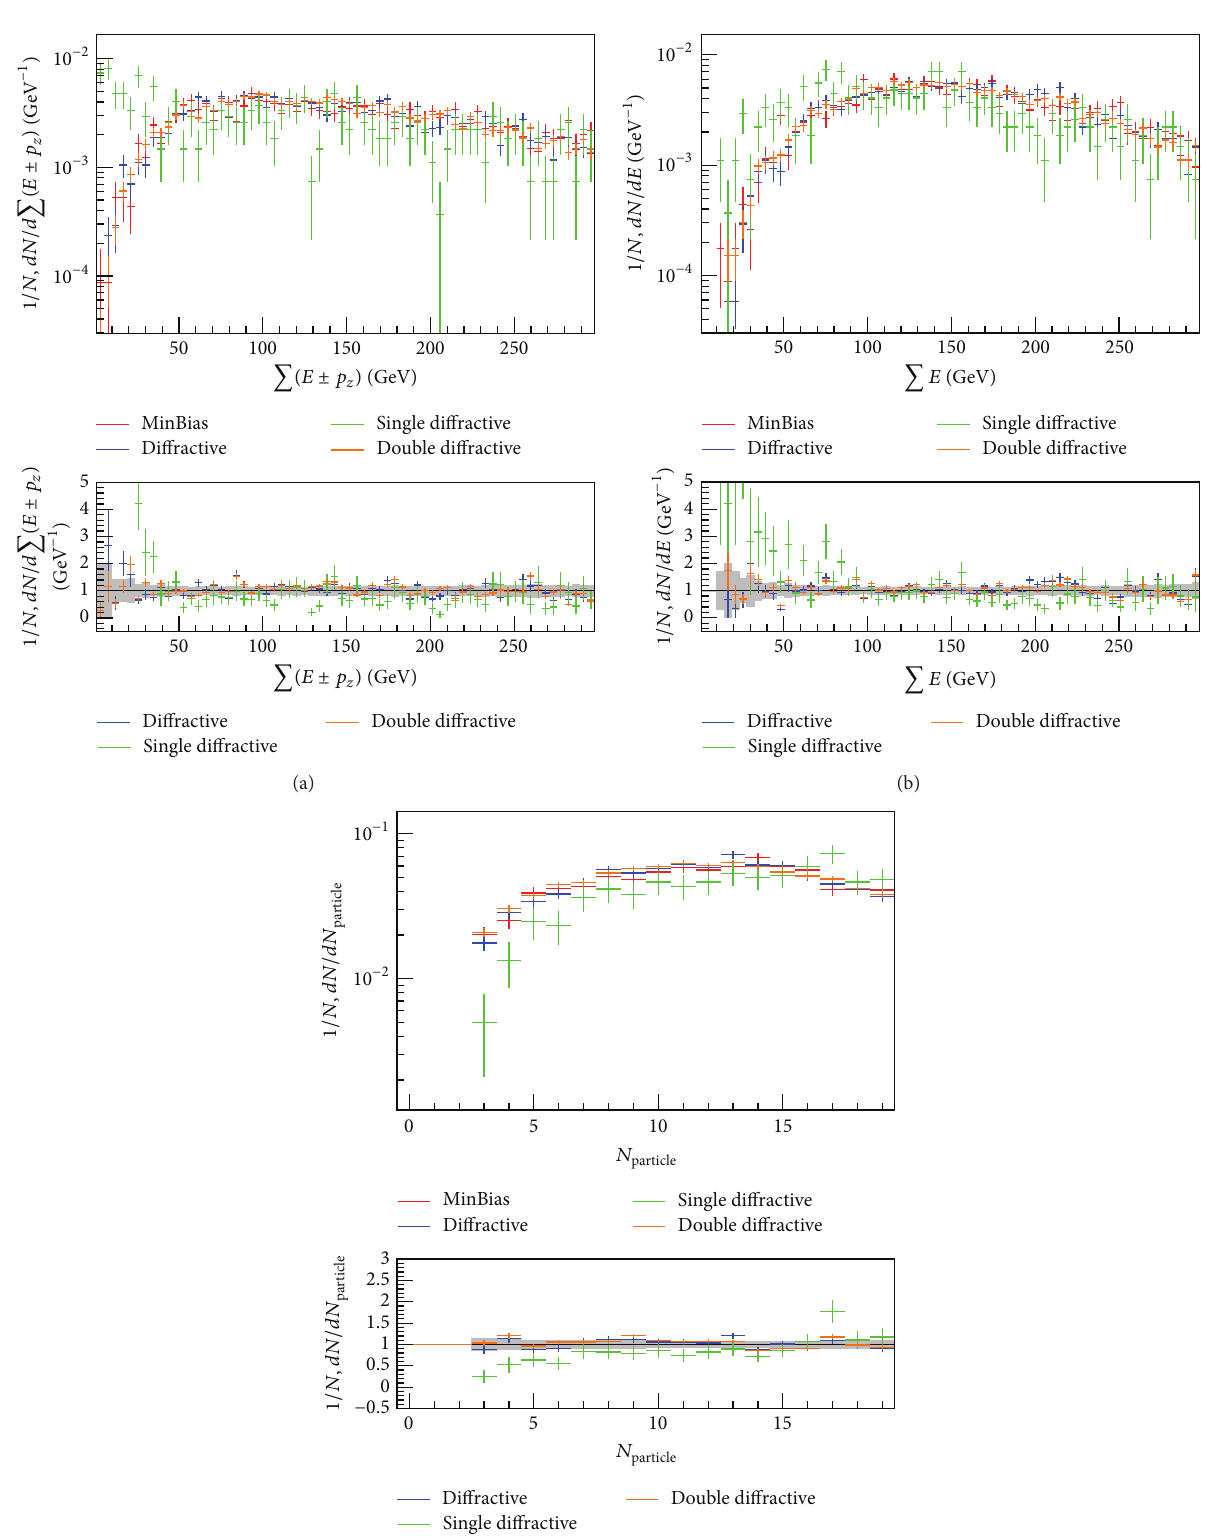
Figure 11: Distributions of ∑ (𝐸±𝑝 𝑧 ) (a), total energy deposition (b), and particle multiplicity (c) for the events that have a central gap Δ𝜂 > 4 with a 𝑝 T > 200 MeV cut on final state particles in |𝜂| < 5.2 . The distributions are normalized to the number of events, N , that pass the analysis cuts. The MinBias event class is used as a reference for the